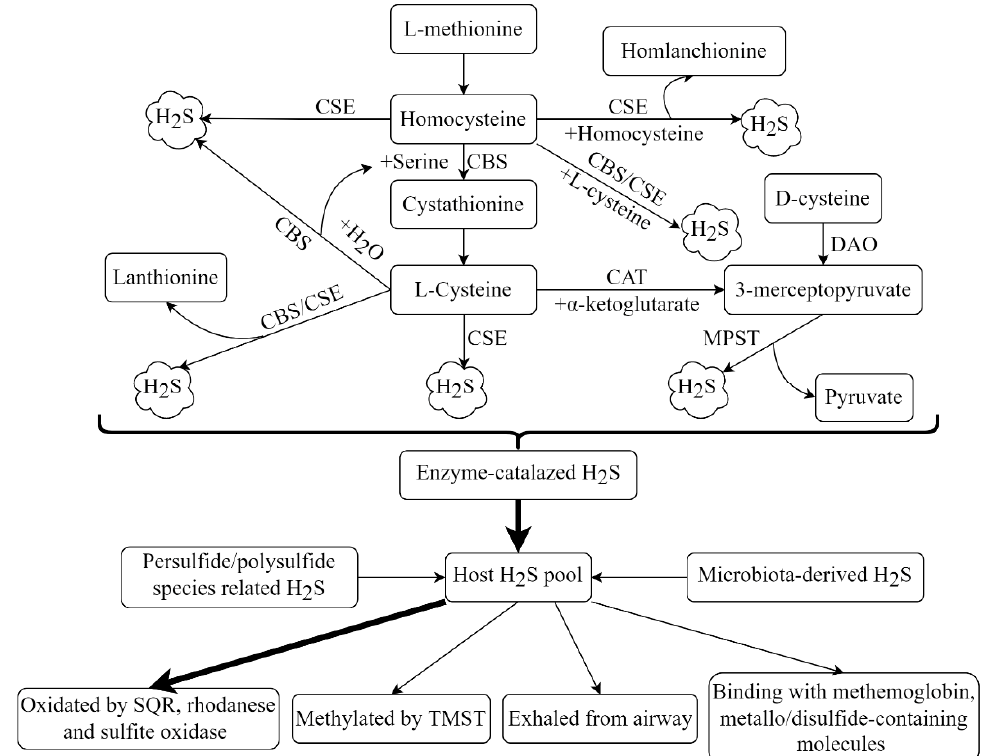
Figure 1. Overview of hydrogen sulfide (H 2 S) metabolism in mammals. Endogenous H 2 S is mainly produced by the desulphydration of L-cysteine or homocysteine by the enzymatic reactions cata- lyzed by cystathionine β -synthase (CBS), cystathionine γ -lyase (CSE), 3-mercaptopyruvate sul- furtransferase (MPST)/cysteine aminotransferase (CAT) and MPST/D-amino acid oxidase (DAO). Endogenous H 2 S is also yielded from the natural release of H 2 S from persulfide/polysulfide species. Sulfate-reducing microorganism-derived H 2 S is also an important source of endogenous H 2 S. The elimination of endogenous H 2 S is mainly achieved by oxidation in the mitochondria by sulfide quinone oxidoreductase (SQR), rhodanese and sulfite oxidase (SO) and methylation in the cytoplasm by thiol- S -methyltransferase (TMST). H 2 S can be directly exhaled from the airways or excreted with biological fluids, such as urine.